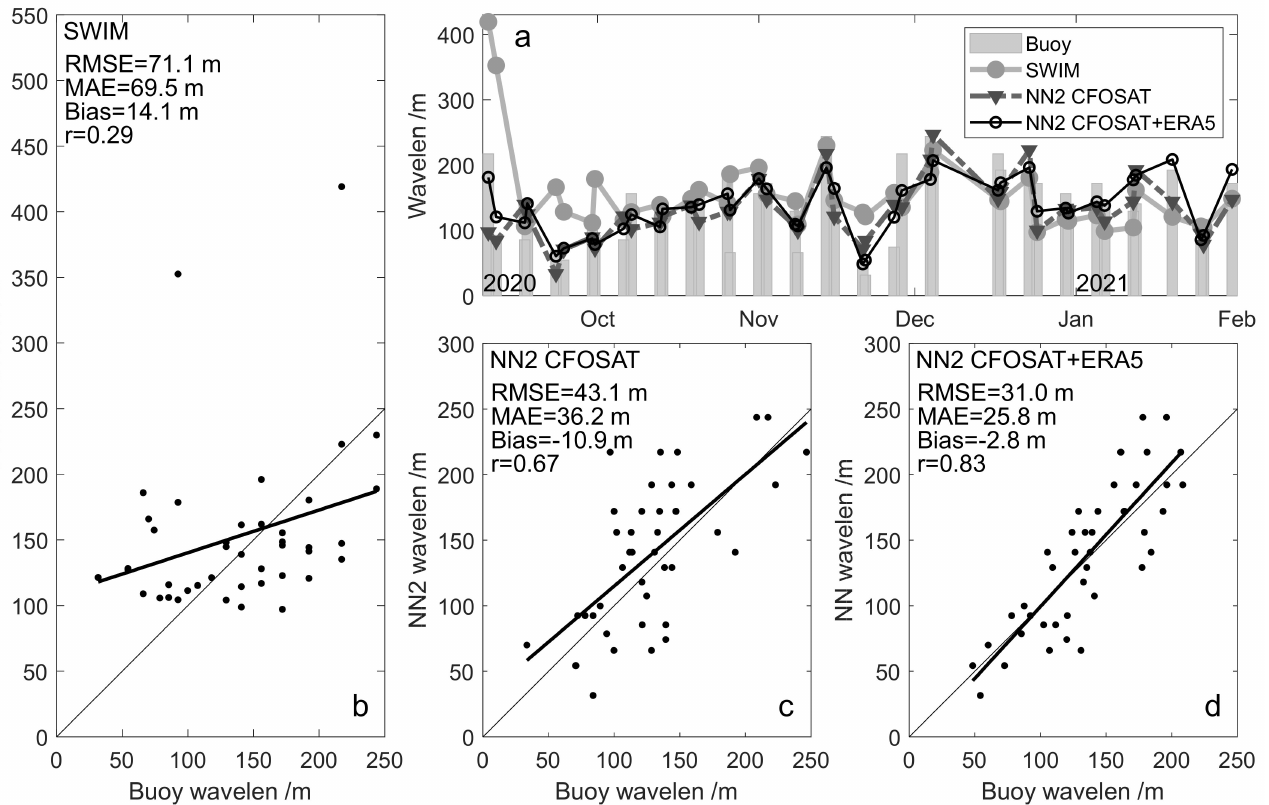
Figure 12. Validation results of the NN2 model with a typical sampling method (former 75% for calibration and latter 25% for validation); ( a ) comparisons of wavelengths by SWIM, NN2 model, and buoy A in time series; ( b ) comparisons of wavelengths by SWIM and buoy A in scatters; ( c , d ) scattering comparisons of wavelengths from buoy A and NN2 model with CFOSAT parameters and CFOSAT + ERA5 parameters,